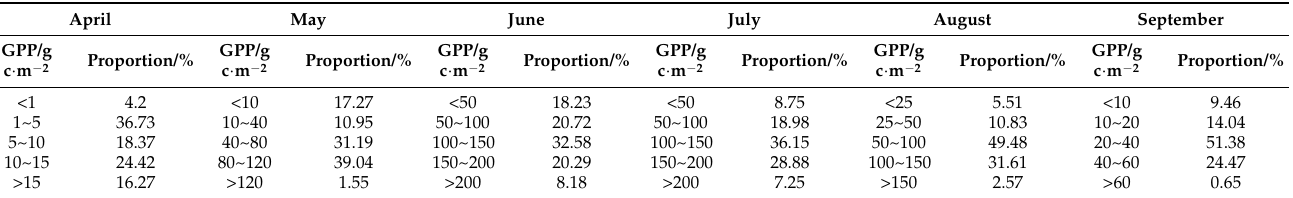
Table 2. The proportion of the areas with different GPP in the growing season in the Altay Mountains.